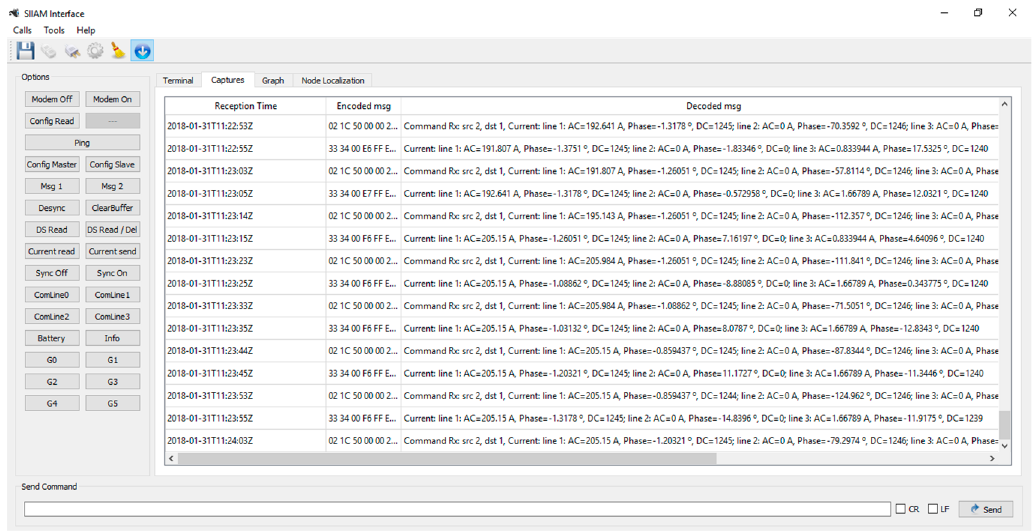
Figure 14. Basic operating principle of impedance-based location method [8].